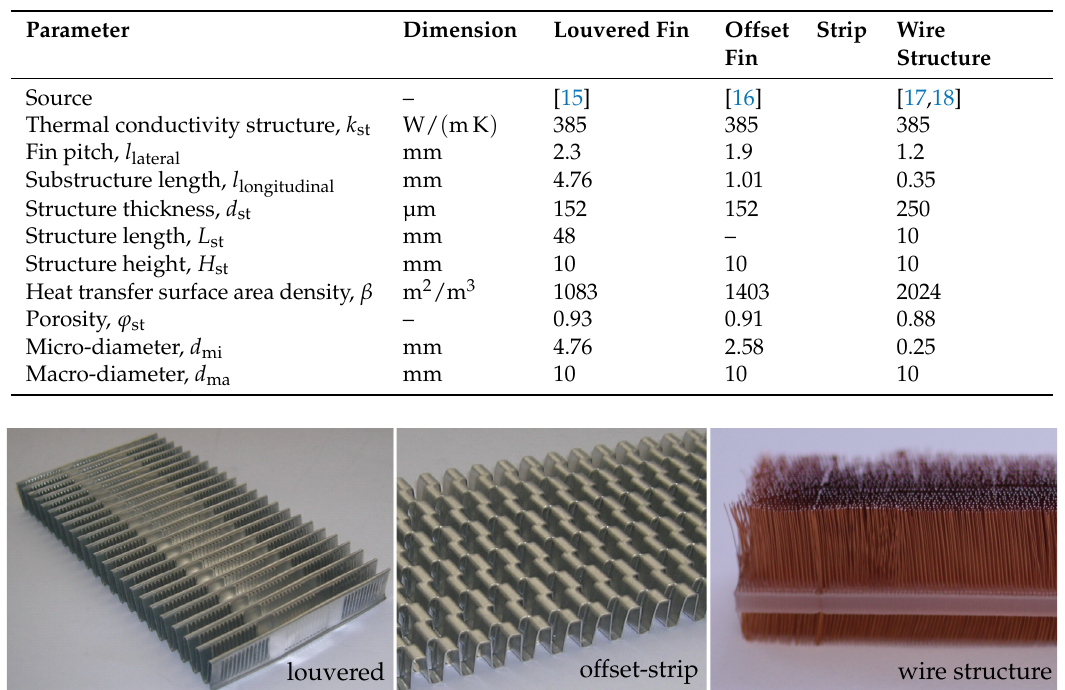
Table 4. Dimensions of exemplary heat transfer enhancements.